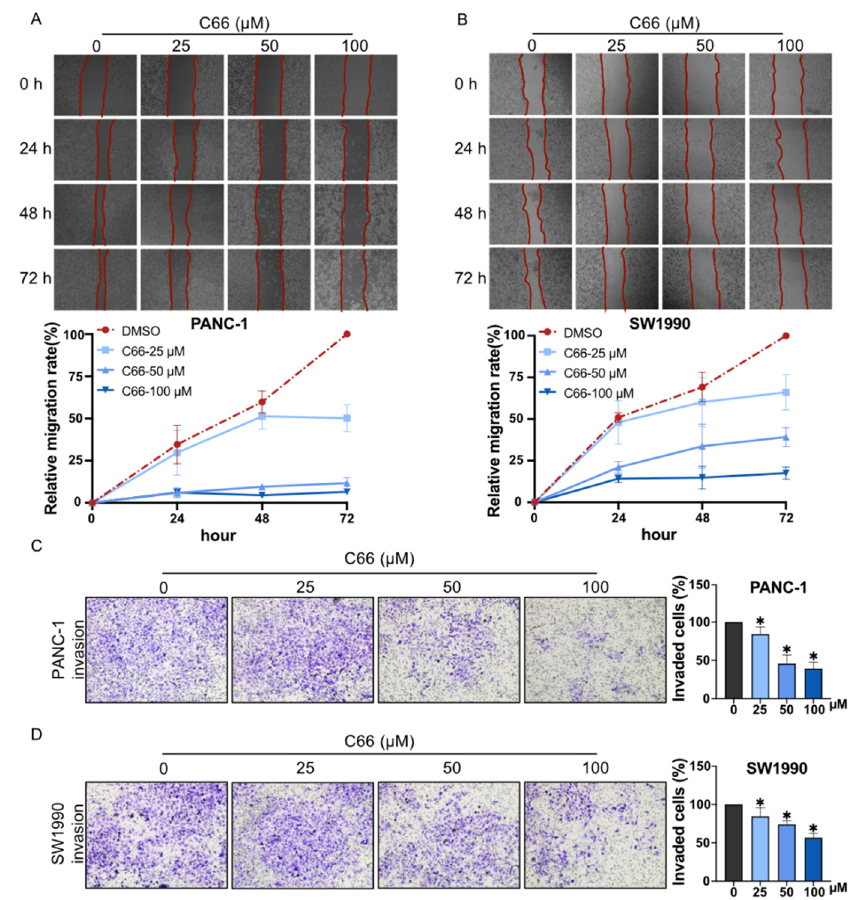
Figure 4. Inhibition of the migration of pancreatic cancer cells by C66. Scratch wound ( A , B ) and transwell ( C , D ) assay assessed the inhibition of cell migration after C66 (25, 50, or 100 μ M) treatment of PANC-1 and SW1990 for 3 days. Each bar represents mean ± SEM of three independent experiments. n = 3, * p < 0.05, compared with the matching control.